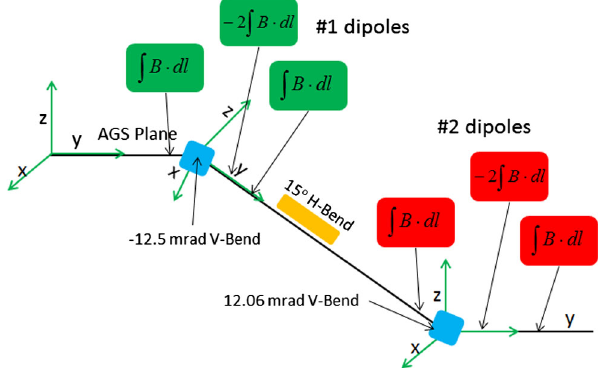
FIG. 2. The first section of the AtR line where the beam is bent simultaneously along the vertical (blue rectangles) and horizontal (yellow rectangle) planes by 12.5 mrad and 15° respectively. The red or green rectangles represent proposed dipole magnets which can be placed at these locations along the AtR line to rotate the stable spin direction and match it to that at the RHIC injection point.